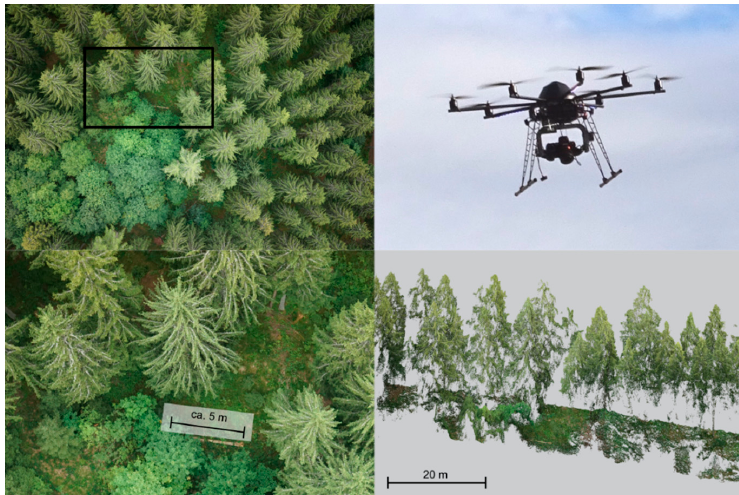
Figure 2. UAV image acquisition; the top-left panel shows a raw image of the UAV ( top right ). The lower-left panel shows a close-up of the same image (frame in top left image) with a log of ca. 5 m length. The lower-right panel illustrates a transect of the resulting point cloud.